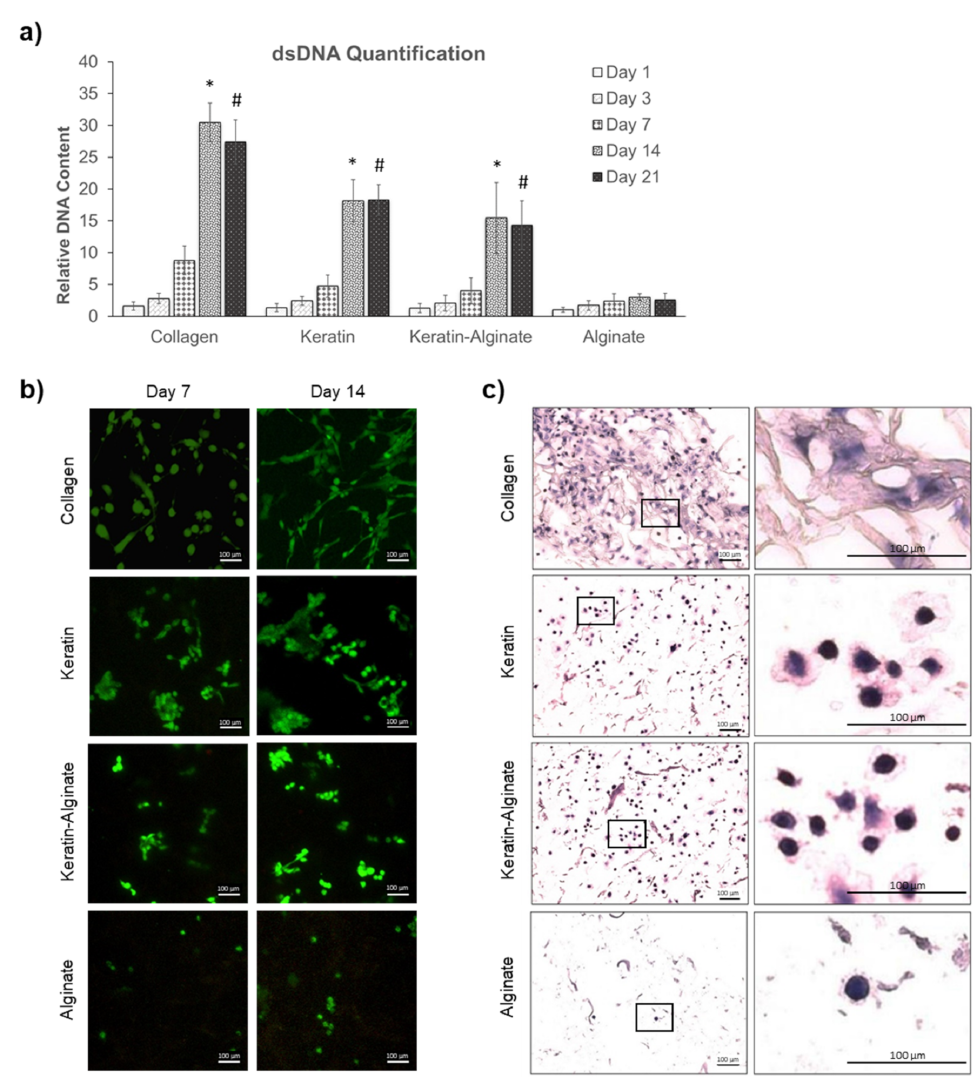
Figure 2. Evaluation of HDF proliferation, viability, morphology, and distribution in the various templates tested. ( a ) Relative amounts of dsDNA over time. Data were normalized against day 1 alginate samples. Each bar represents mean ± SD ( n = 4). *, # p < 0.05 vs. alginate (one-way analysis of variance (ANOVA) and Tukey’s test). ( b ) Live–dead staining images of HDFs cultured in the various templates using the confocal laser microscope. Live cells were stained green (scale bars: 100 µ m). ( c ) H&E staining of HDFs after 14 days of culture (scale bars: 100 µ m). Rectangles within the left panel images indicate the regions of interest magnified in the right